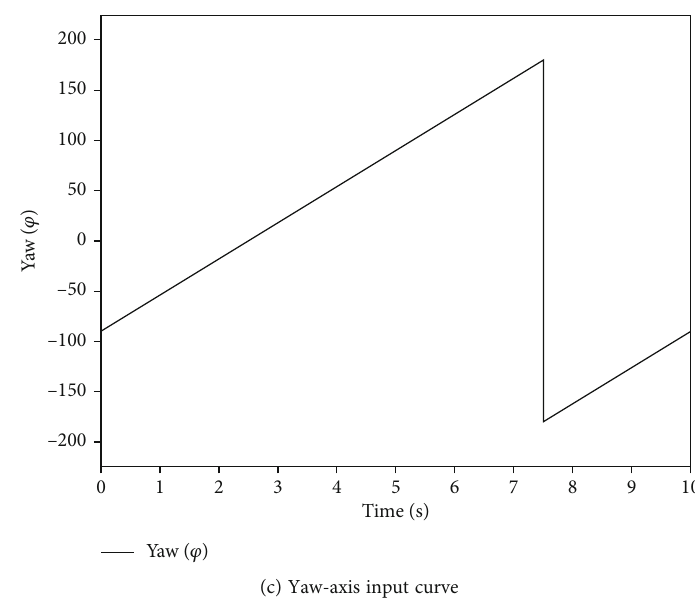
Figure 9: Circular curve design.